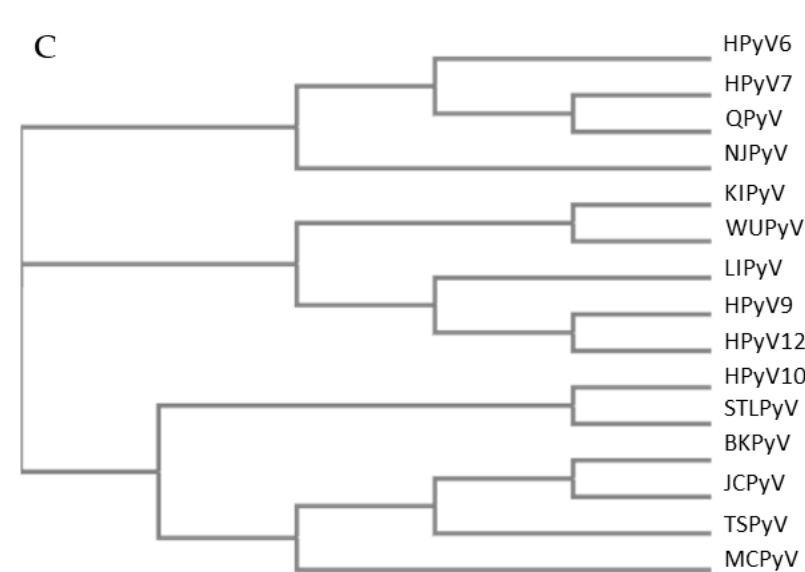
Figure 1. Genomic organization of the human polyomaviruses (HPyVs) genome and the structure of the noncoding control region (NCCR). ( A ) The circular dsDNA genome consists of the early and late regions that encode regulatory and structural proteins, respectively. Interspersed is the NCCR. ( B ) Schematic presentation of the NCCR of the novel HPyVs. The NCCR is the region between the start codon of Large T antigen (LT) and Small T antigen (sT) and the start codon of VP2. The AT-rich region (AT), repeated sequences (black dots), and LT binding motifs (upward pointing triangle = 5 ′ -GRGGC-3 ′ ; downward pointing triangle = 5 ′ -GCCYC-3 ′ ) are shown. ( C ) Phylogenetic tree bases on NCCR sequences of the different HPyVs. This is a neighbor-joining tree without distance corrections using Clustal Omega multiple sequence alignment [34].